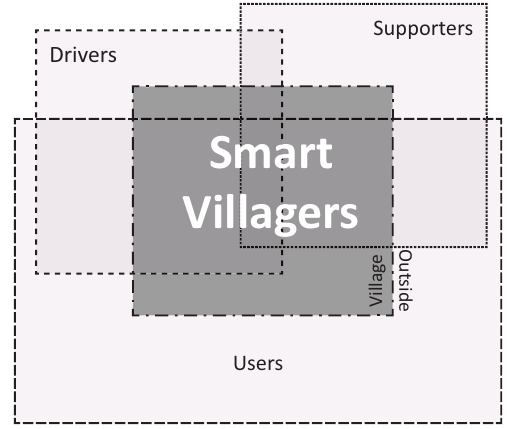
Figure 1. Smart Villagers in rural